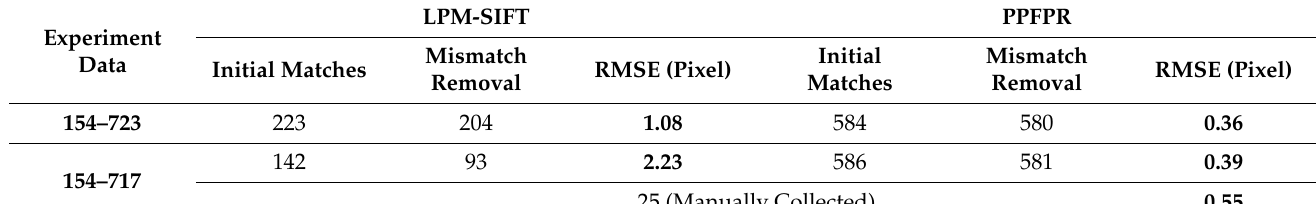
Table 3. Matching and single-image calibration results.